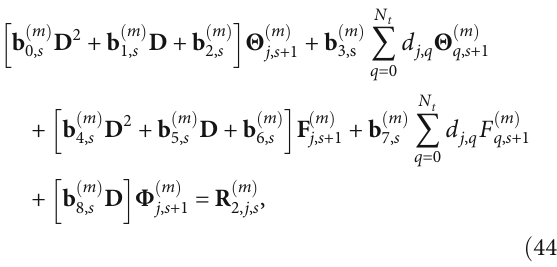
Figure 12: Concentration pro fi le for di ff erent values of Pr when De = 0 : 1, N = 0 : 5, n = 0 : 5, f = δ = NR = 0 : 2, Sc = 0 : 6 , and Pr = 1 :